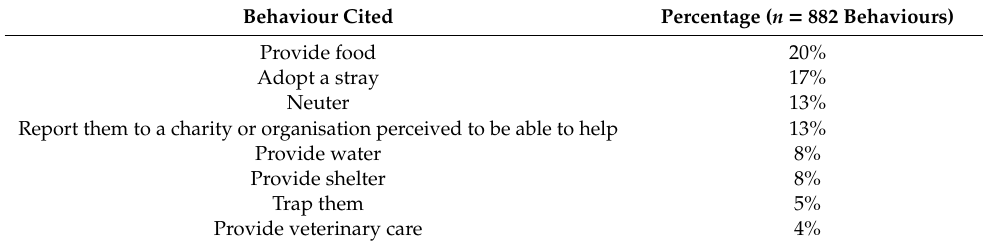
Table 1. Most commonly cited behaviours perceived to help unowned cats from free-text survey